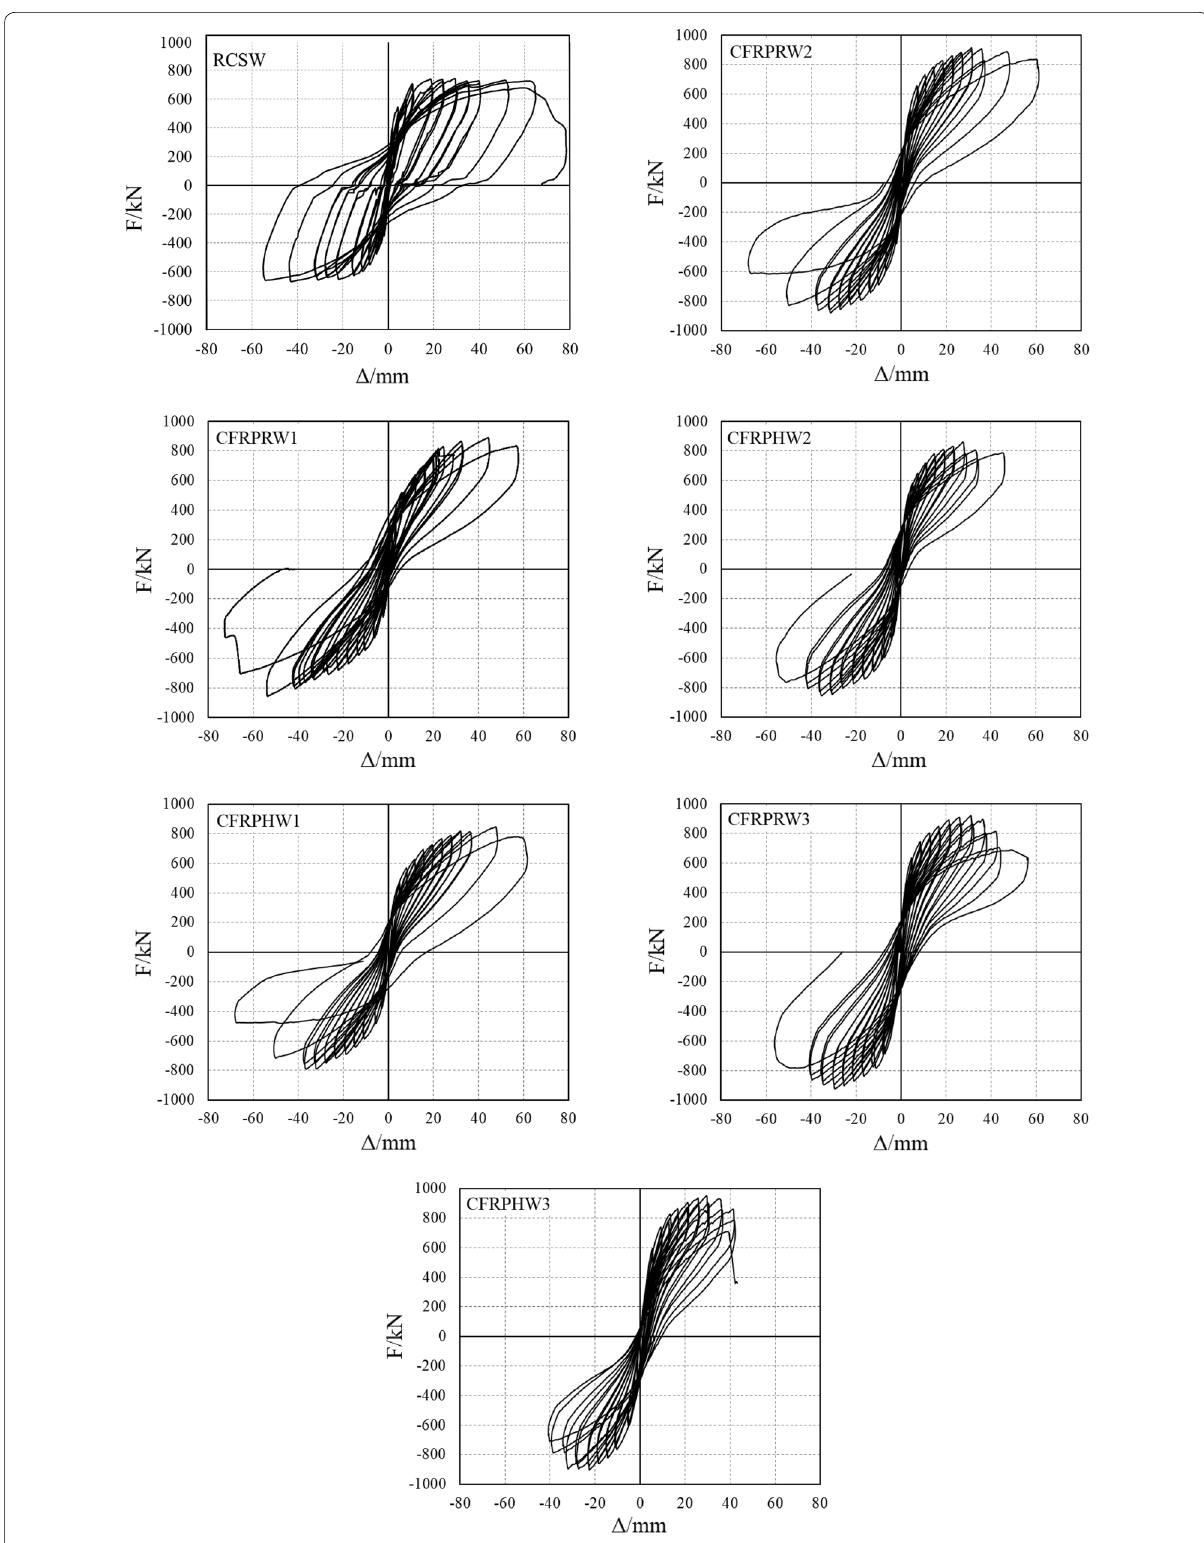
Fig. 8 Hysteretic